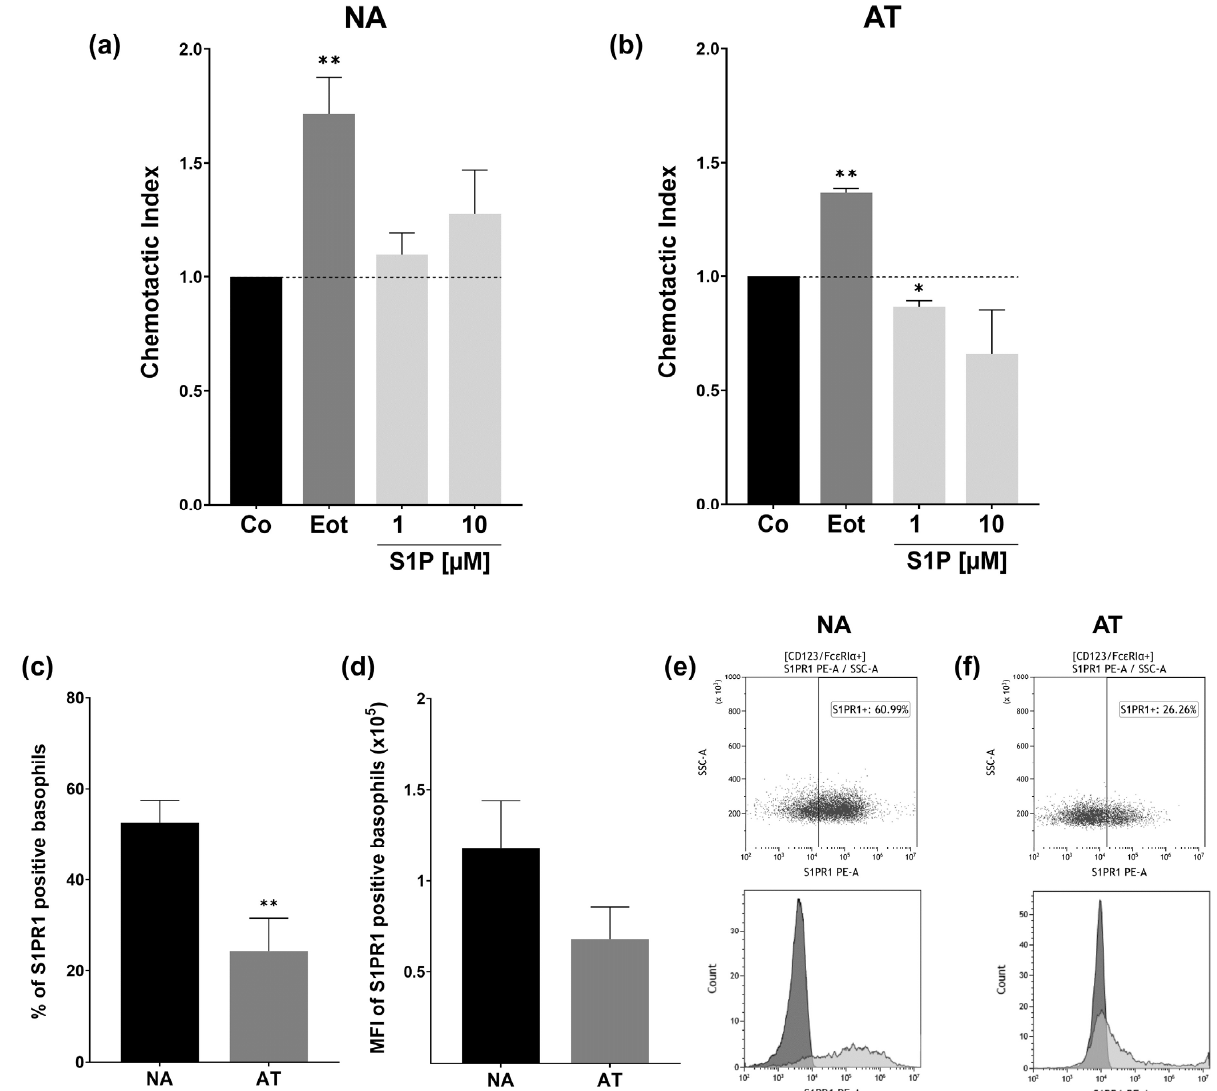
Figure 5. Chemotaxis assay and S1PR1 protein expression. Basophil chemotactic activity and flow cytometry analysis of S1PR1 protein expression in NA and AT patients. NA = non-atopic, AT = atopic, SSC = side scatter. Basophils were placed in the upper chamber of a transwell migration assay, and chemotactic activity toward stimuli in the bottom chamber was measured. Cells were counted after 3 h through flow cytometry. Fatty acid free BSA (Co), S1P (1 and 10 µM), or eotaxin (Eot) (8 ng/mL) were applied in FCS-free RPMI. The chemotactic index was calculated in relation to the transmigrated cells in the Co group. ( a ) Chemotactic index of NA basophils ( n = 6). Basophils are significantly attracted to eotaxin. ( b ) Chemotactic index of AT basophils ( n = 3). Basophils migrate towards eotaxin, whereas 1 µM S1P significantly reduces the number of transmigrating cells. ( c ) Flow cytometry analysis of protein level S1PR1 expression. Percent of S1PR1 positive basophils of NA ( n = 6) and AT ( n = 5) patients. AT patients express significantly less S1PR1 on the cell surface than the NA group. ( d ) Flow cytometry analysis of S1PR1 MFI in NA ( n = 6) and AT ( n = 5) basophils. ( e ) Representative dot plot of S1PR1 protein expression in NA basophils (top) and representative histogram of S1PR1 (light grey) and isotype control (dark grey) stained NA basophils (bottom). ( f ) Representative dot plot of S1PR1 protein expression in AT basophils ( top ) and representative histogram of S1PR1 (light grey) and isotype control (dark grey) stained AT basophils ( bottom ). Data shown as mean + SEM, p -values (* ≤ 0.05; ** ≤ 0.01). Significances are calculated in relation to the Co or NA group.